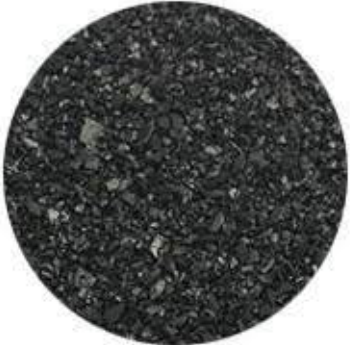
Figure 2. Morphology of activated